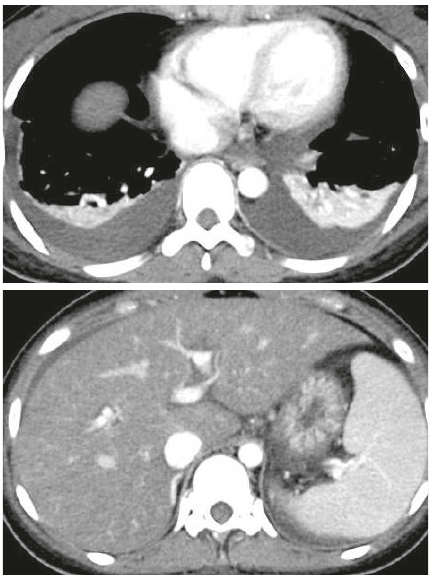
Figure 1: Dynamic contrast-enhanced CT scan.